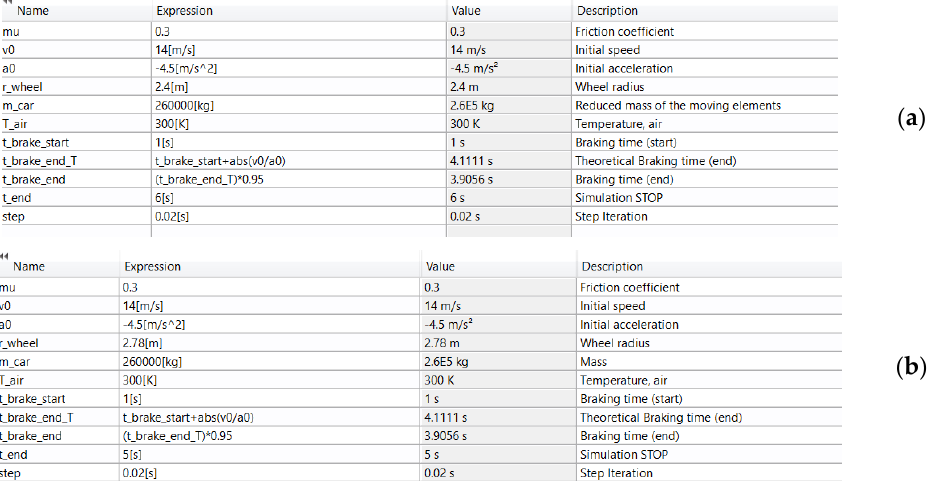
Figure 14. Definition of initial simulation parameters in COMSOL: ( a ) drum-and-shoe brake sys- tem; ( b ) disc-and-pads brake system.